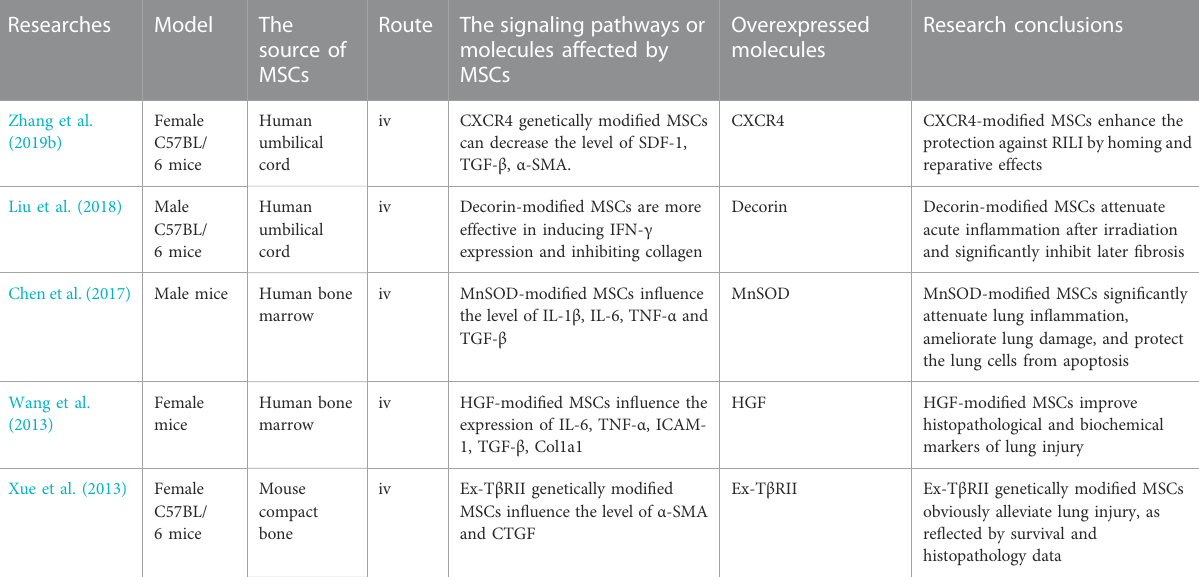
TABLE 2 Current and ongoing studies on MSCs as gene vehicles for the treatment of